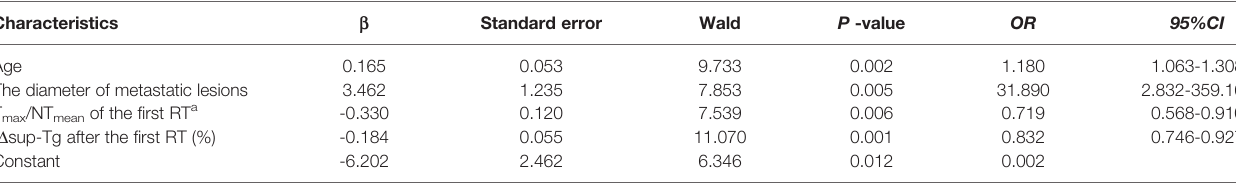
TABLE 4 | Logistic regression analyses of the variables affecting non-remission after RT in 117 patients with m-DTC. Characteristics